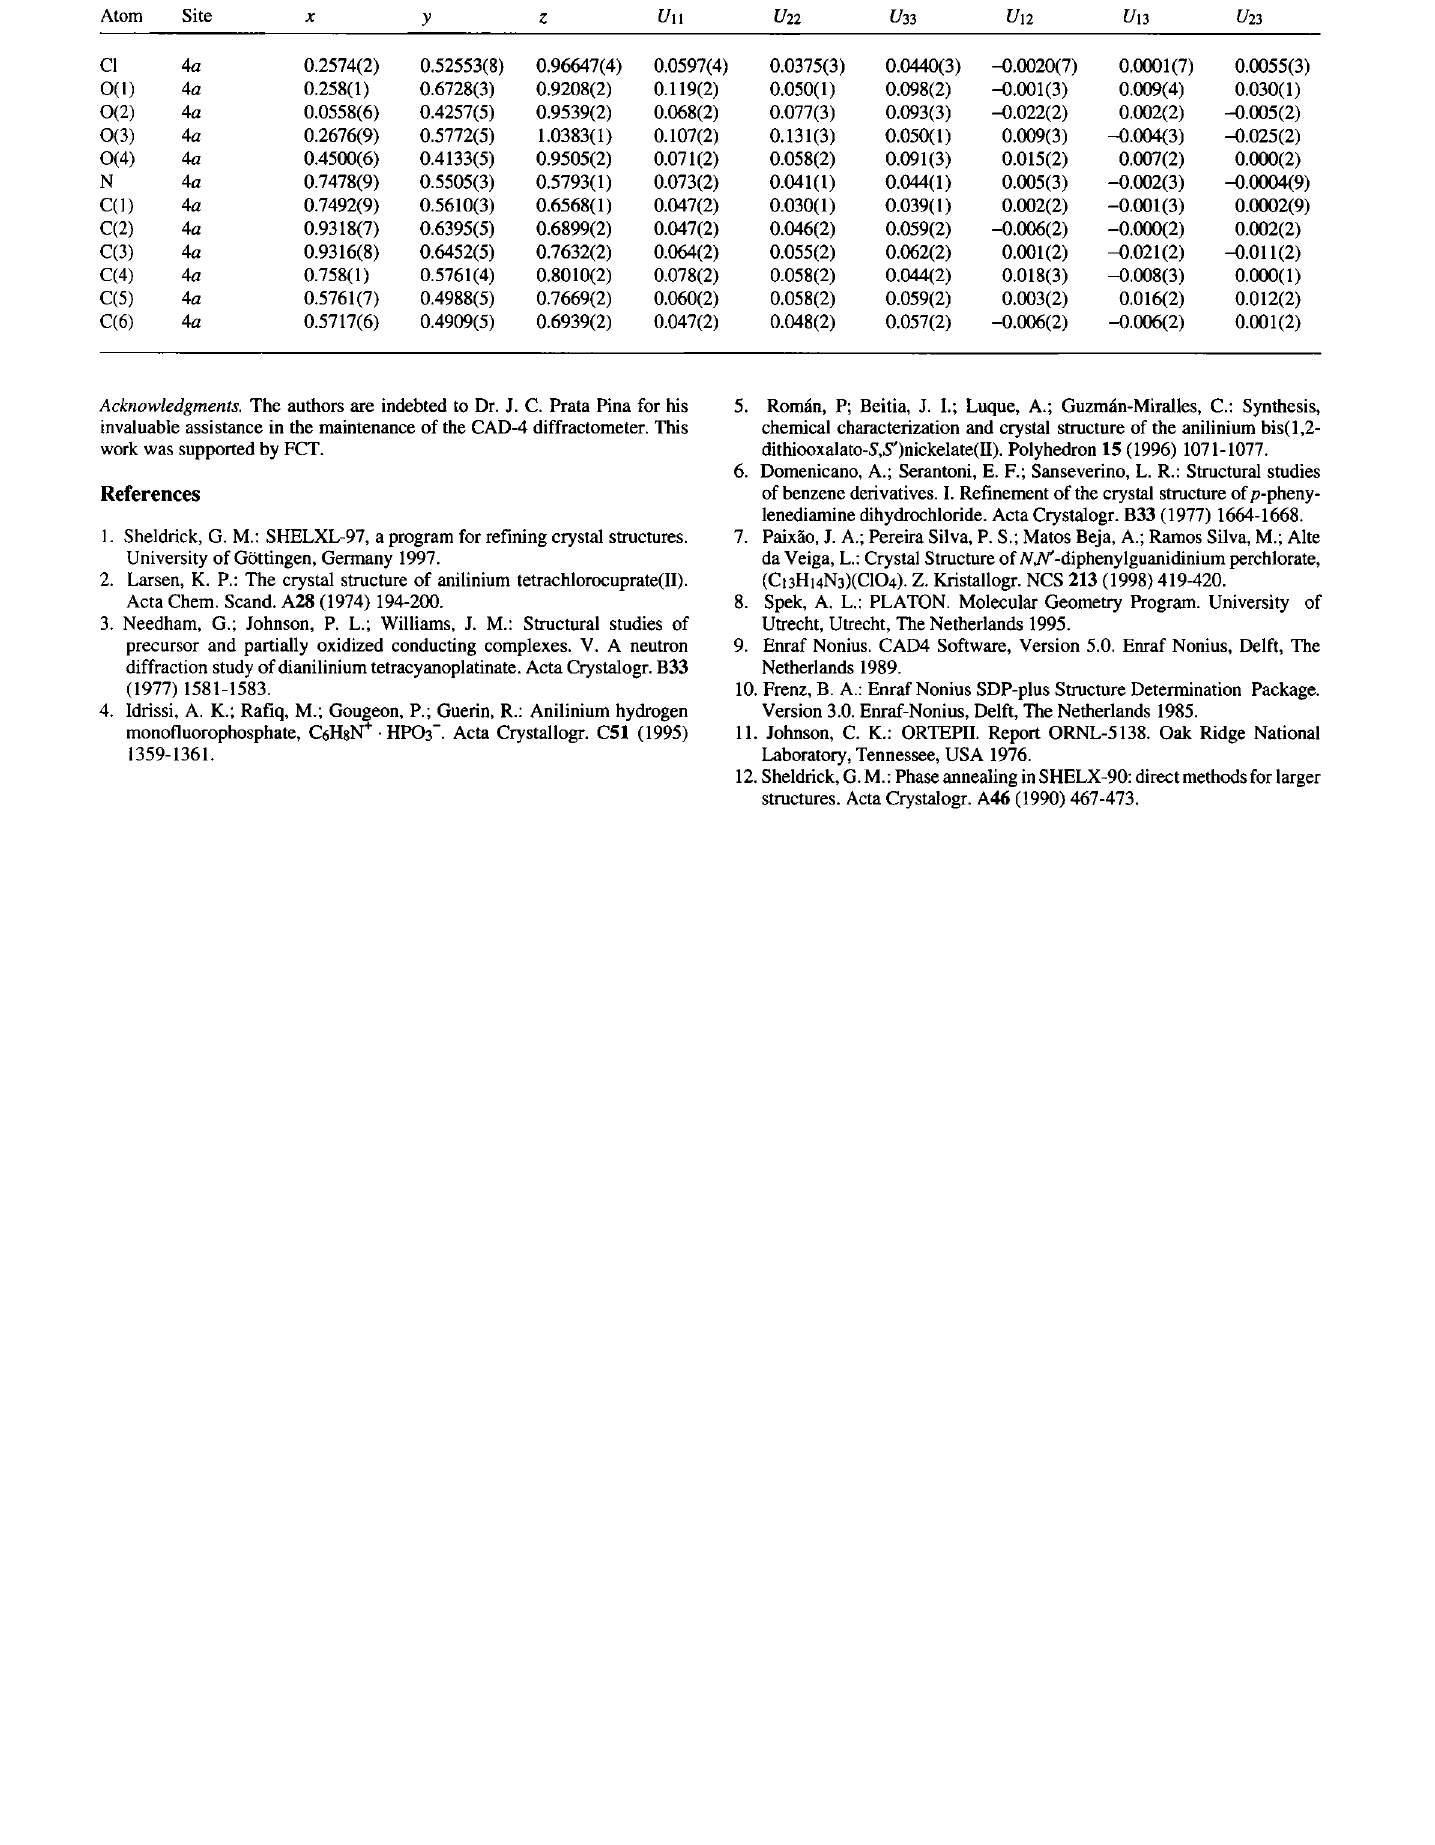
Table 3. Atomic coordinates and displacement parameters (in Â 2